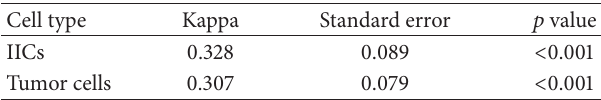
Table 5: Immunohistochemical agreement of PD-L1 expression in individual analysis versus collective analysis considering cell type.